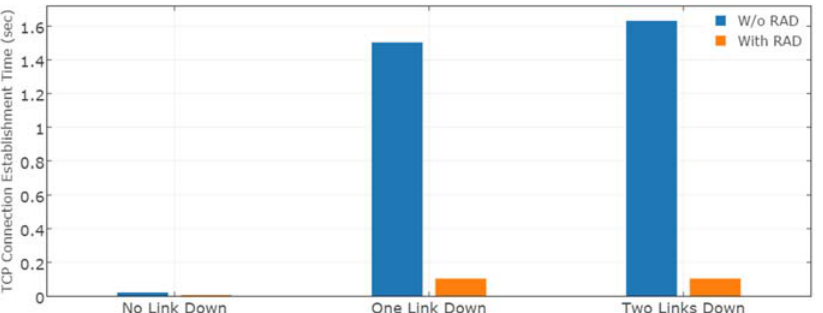
Figure 7. Average connection time (s) vs. the number of links down.